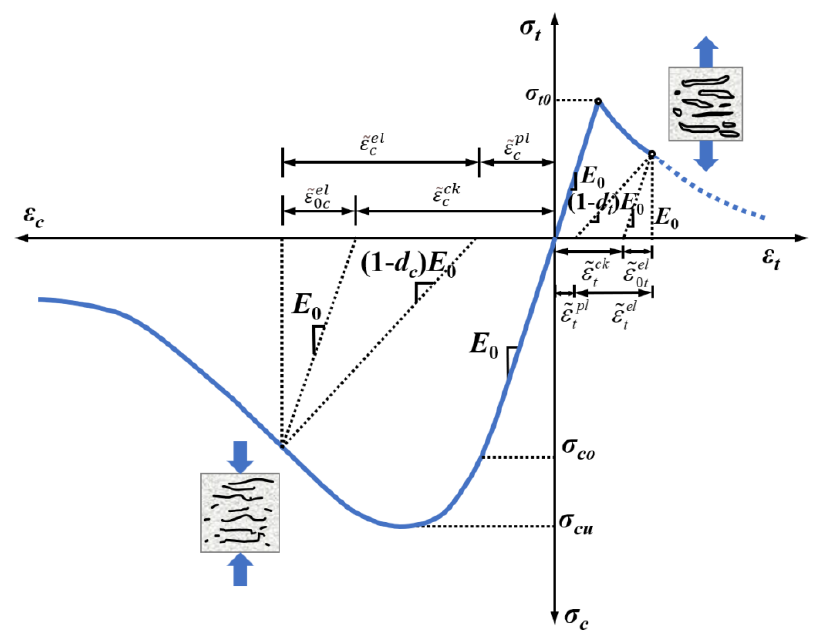
Figure 21. Uniaxial compressive and tensile concrete damage plasticity constitutive model. The expansion angle, eccentricity, ratio of biaxial compressive strength to uniaxial compressive ultimate strength, invariant stress ratio, and viscosity parameters in the con ‐ crete CDP principal model were taken as 30, 0.1, 1.16, 0.6667, and 0.0005, respectively [64]. In the numerical simulation, due to the relatively large number of divided elements, the damage constitutive model of a relatively simple form is chosen to ensure the efficiency and accuracy of the calculation, provided that the calculation requirements are met. Since the major difference between LHPCC and OPC lies in the composition and the early heat of hydration, there is no significant difference in the damage morphology of the specimens and the tendency of the σ ‐ ε curve. Therefore, the parameters of the CDP model are deter ‐ mined using the concrete constitutive relations provided by GB50010 ‐ 2010 [65] in this paper. Among them, the stress-strain relationship for concrete in uniaxial tension is shown in Equations (6)–(9).